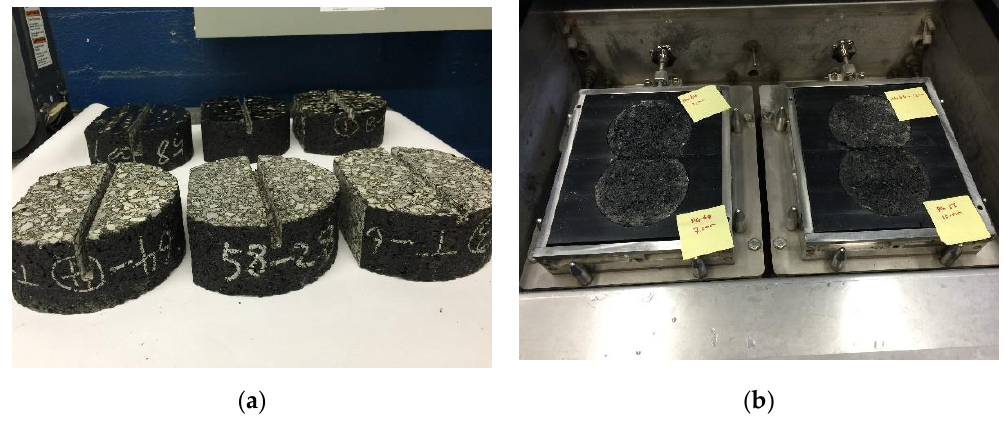
Figure 11. Specimens #7, #8, and #9 (2.4-inch thickness, 10 days aging, with a notch), ( a ) specimen with varied notch depth, and ( b ) specimen placed in molds.